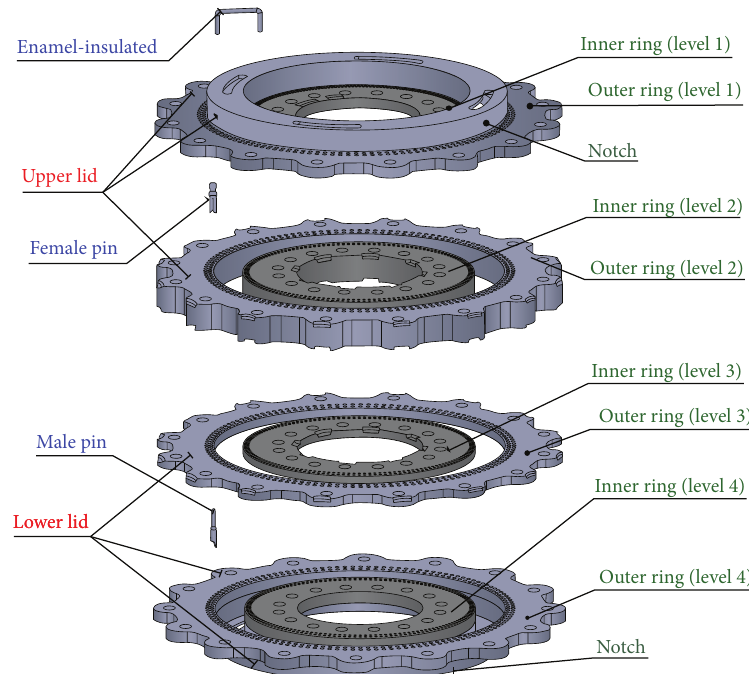
Figure 4: Components of the new toroidal frame.